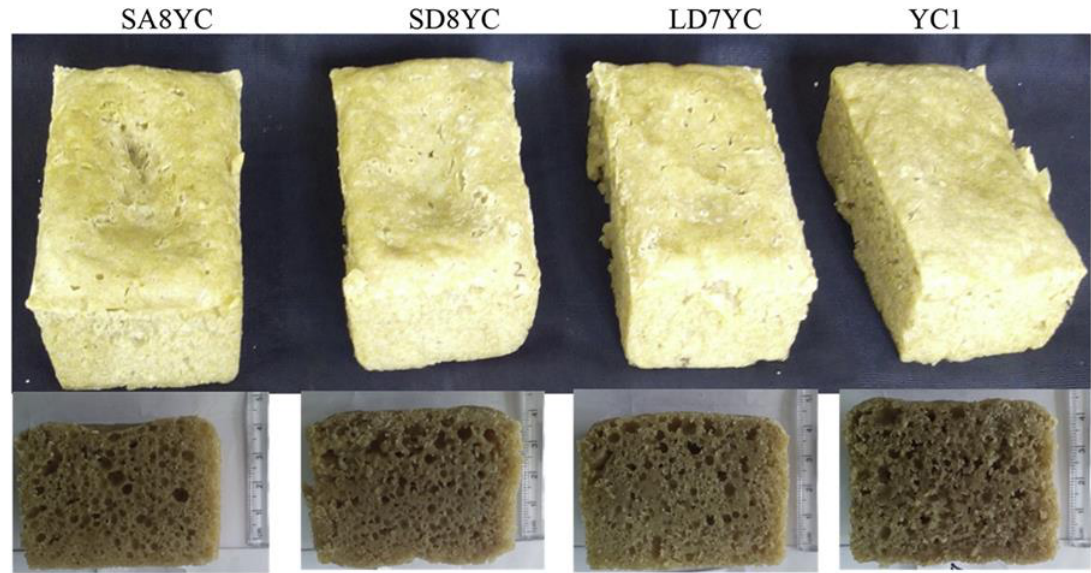
Figure 1. External appearance and internal structures of starter culture (Pediococcus pentosaceus SA8, Weissella confusa SD8, P. pentosaceus LD7, and Saccharomyces cerevisiae YC1) which produced sorghum sourdough breads. Reproduced from Olojede et al. [169]) with permission from the publisher.